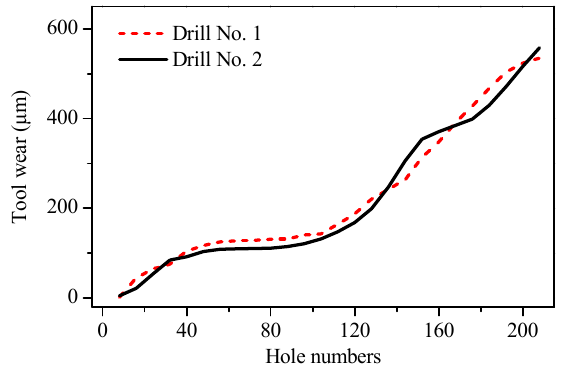
Figure 9. Drilling tool-wear curves.